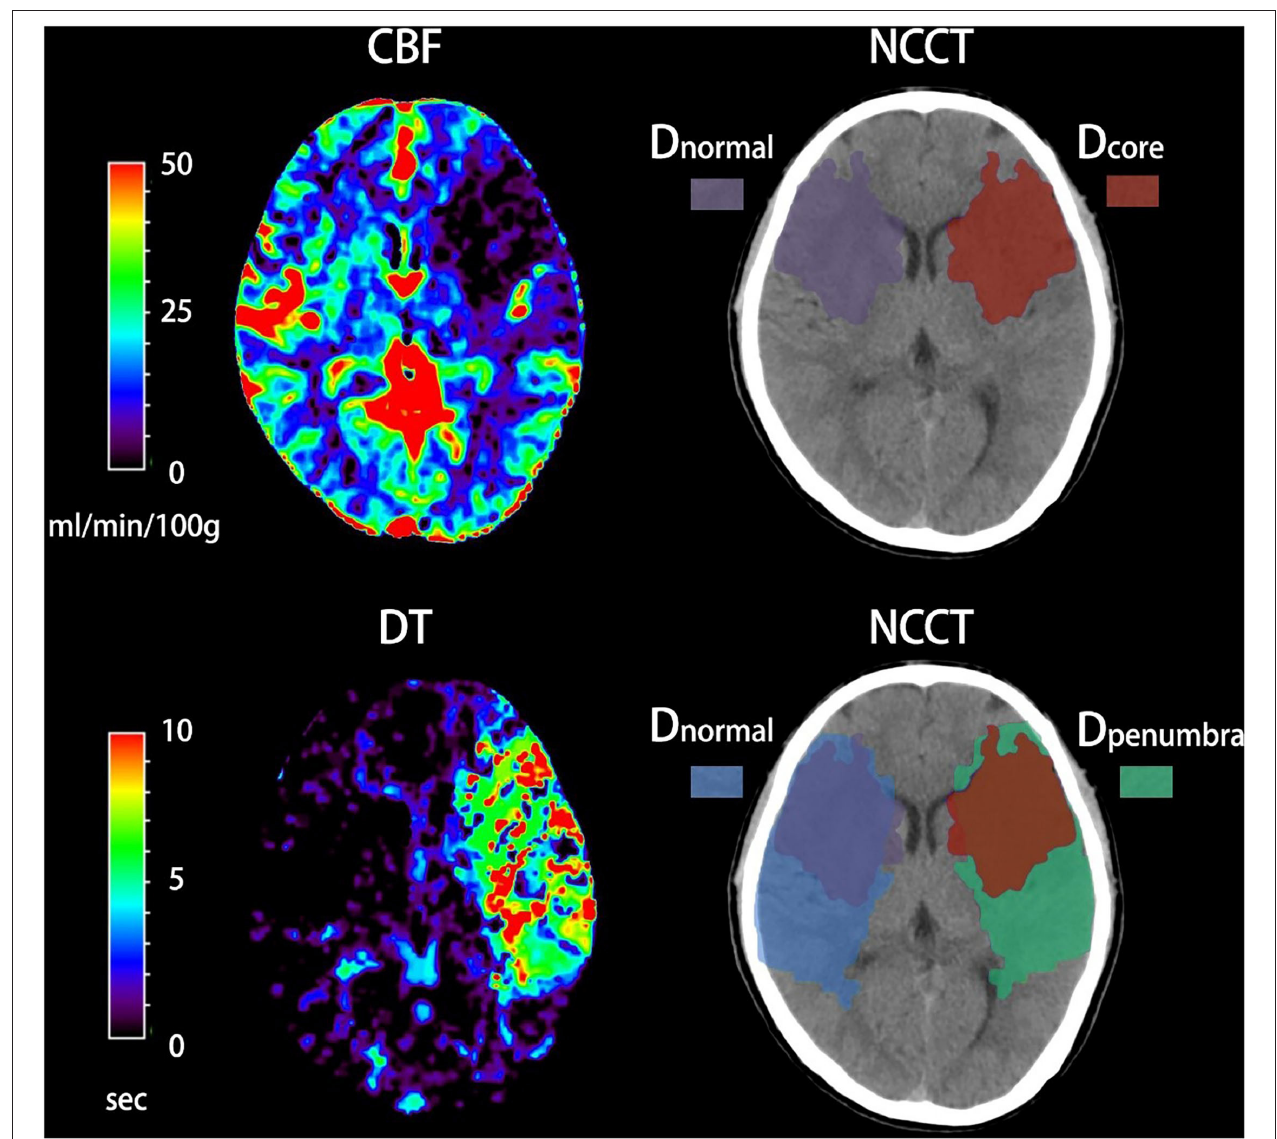
FIGURE 1 | Quantification of net water uptake (NWU) per volume of early infarct in admission non-contrast computed tomography (NCCT). The ischemic core and penumbra were identified by cerebral blood volume (CBV) and delay time (DT) maps based on computed tomography perfusion (CTP). The mean density of early infarct (D core and D penumbra ) and the normal tissue (D normal ) derived from a mirrored contralateral region of interest were then